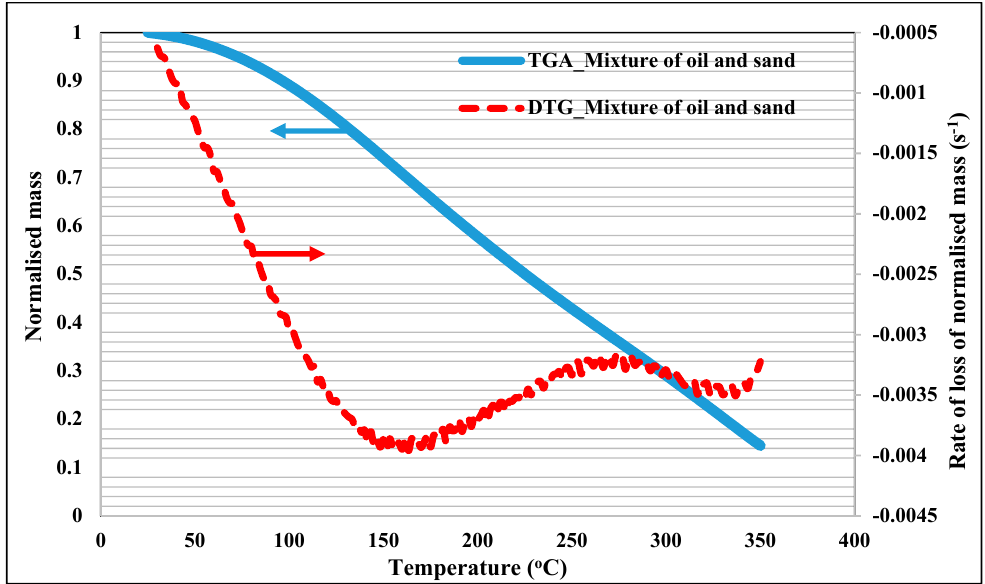
Figure 3. The TG and DTG results of the mixture of oil and sand (Heating rate = 10 ◦ C / min).